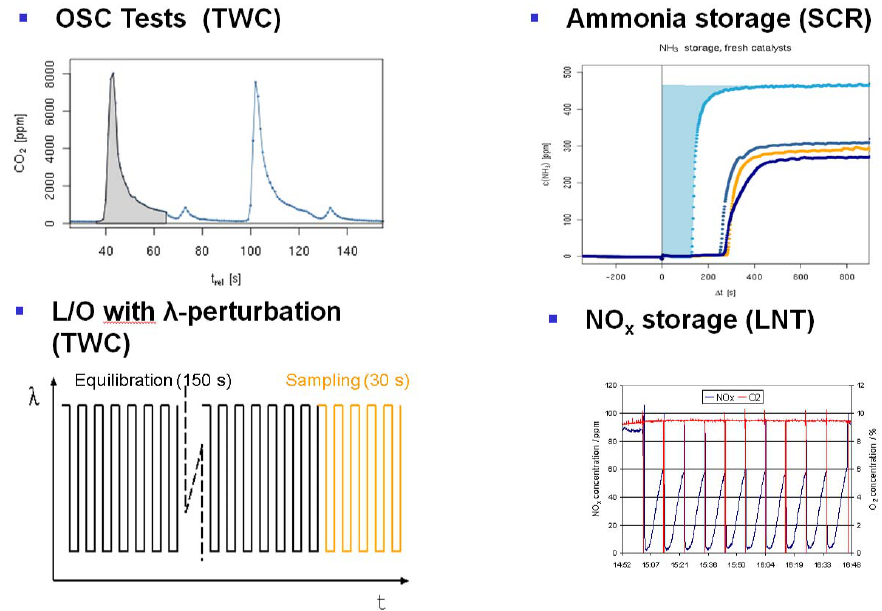
Figure 9. Examples for dynamic test protocols implemented on a 48-fold reactor system. Top left: OSC test, cycling O 2 and CO containing feed and monitoring CO 2 release in the absence of O 2 in the gas phase, which is a measure for the oxygen storage capacity at a given temperature. Top right: NH 3 storage test by cycling NH 3 and monitoring the NH 3 breakthrough under SCR reaction conditions ( i.e ., in the presence of NO, O 2 , H 2 O, optionally CO 2 and/or HC). Bottom right: lean NO x traps (LNT) test with repeated rich regeneration cycles with defined λ . The NO x breakthrough is monitored and analyzed. Bottom left: TWC testing in a feed with rapid λ oscillations with defined amplitude.